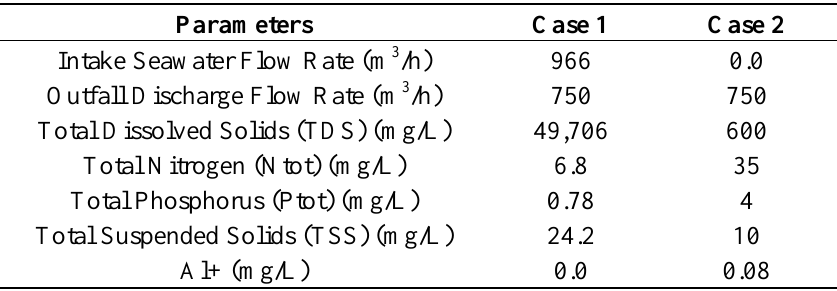
Table 1. Outfall discharge evaluation cases.